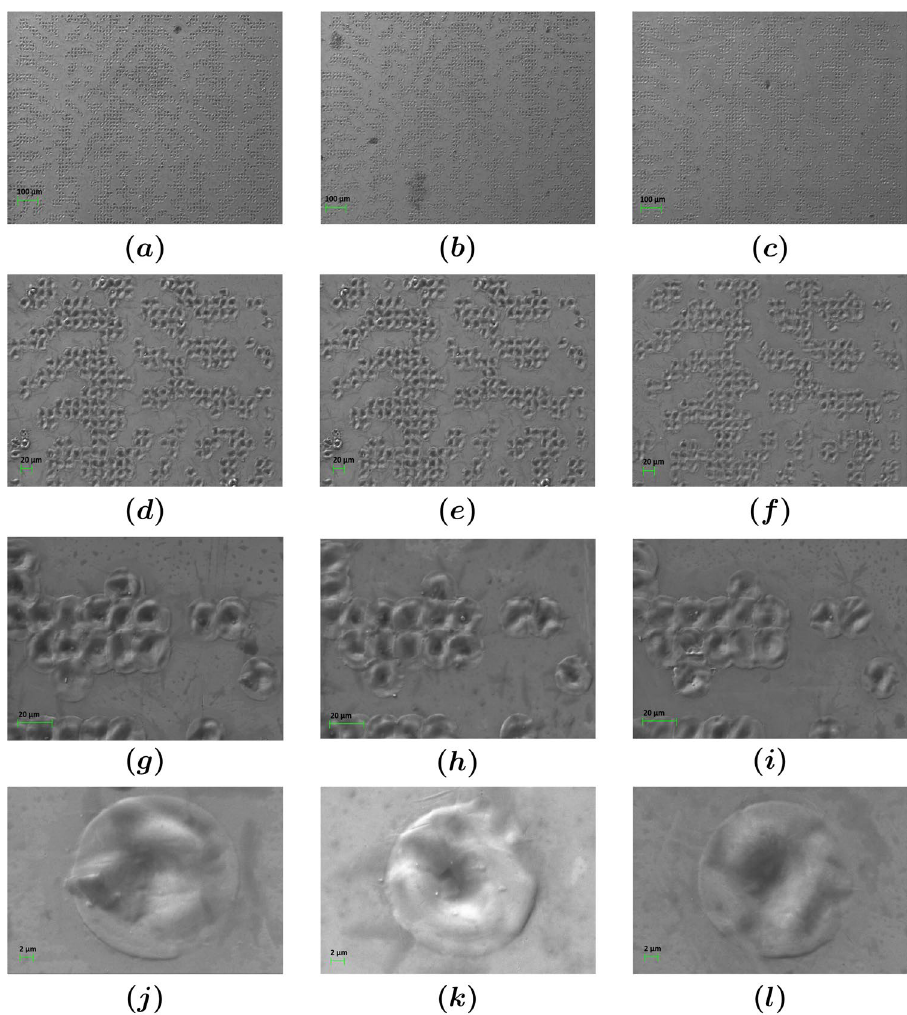
Figure 2. SEM images for three indicative engravings of beam Diffuser structure design (BD3, BD1 and BD5 respectively). Each column corresponds to different engraving and each row to different magnification: ( a – c ) 220X, ( d – f ) 600X, ( g – i ) 1.84KX and ( j – l )